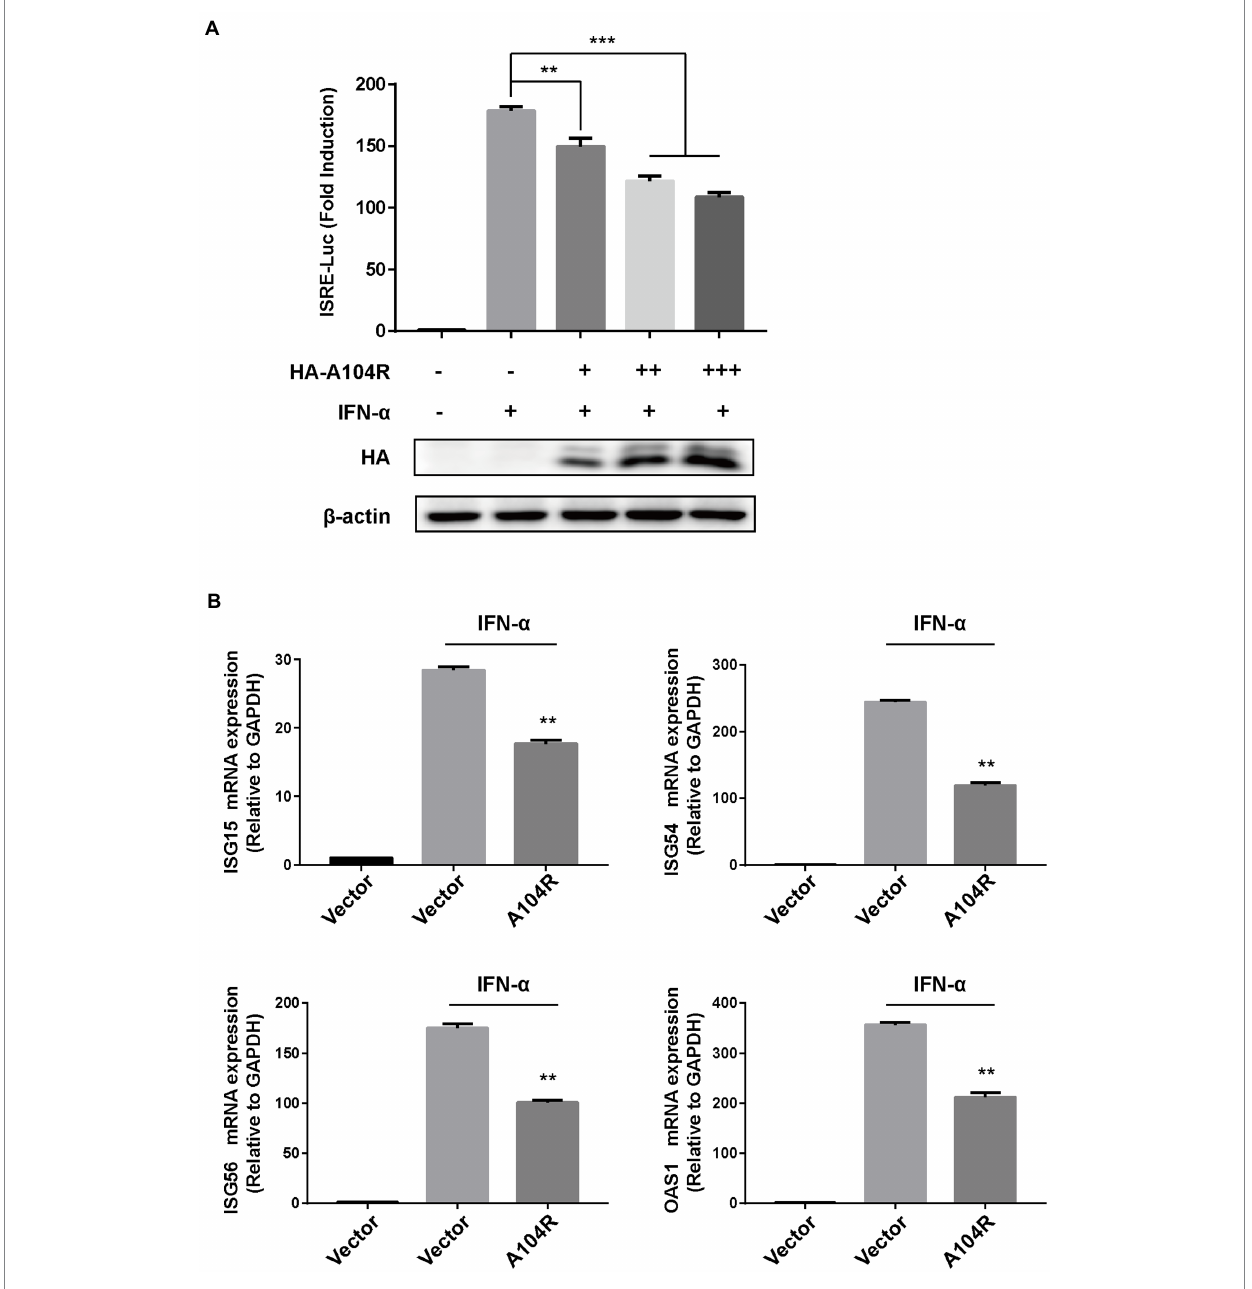
FIGURE 1 ASFV pA104R inhibits type I IFN signaling. (A) HEK-293T cells cultured in 24-well plates were transfected with various concentrations of pA104R plasmids (0, 0.2, 0.4, 0.6 μg/well), or empty vector along with pISRE-Luc and pRL-TK plasmids. After 24 h, cells were treated with 1,000 U/mL IFN- α for 12 h, and luciferase assays were then performed. The protein levels of pA104R were evaluated using immunoblotting analysis. (B) HEK-293T cells were transfected with pA104R, or empty vector. At 24 h post-transfection, cells were treated with 1,000 U/mL IFN- α for 8 h, and the mRNA levels of ISGs were analyzed by RT-qPCR. Statistical analysis was performed using Student’s t-test. All experiments were performed in triplicate, and the data represent mean values ± SEM for triplicates. ** p < 0.01; *** p <